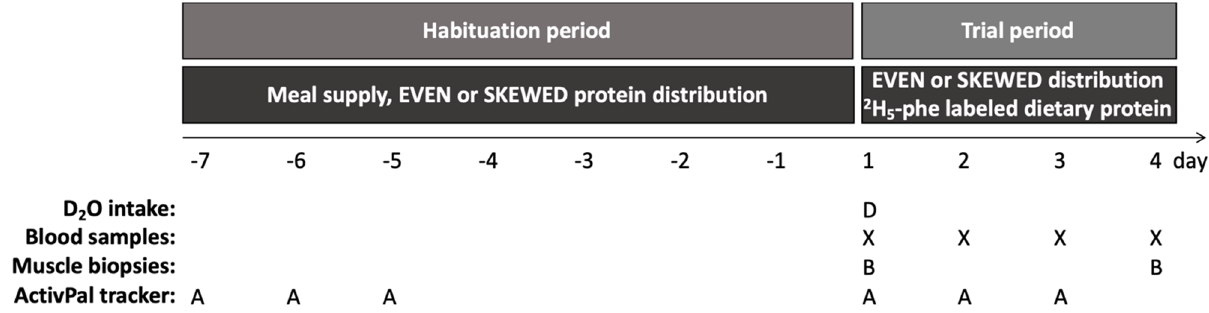
Figure 2. Study design. Indicating the initial 7-day dietary habituation period from day -7 to 1, with habituation to the skewed or even protein distribution by home delivered meals, followed by the three-day trial period started on day 1. Subjects showed up at the hospital from 8.00 a.m. to 18.00 p.m. on all trial days. After background muscle biopsy (B) and blood sample (X) were taken on day 1,